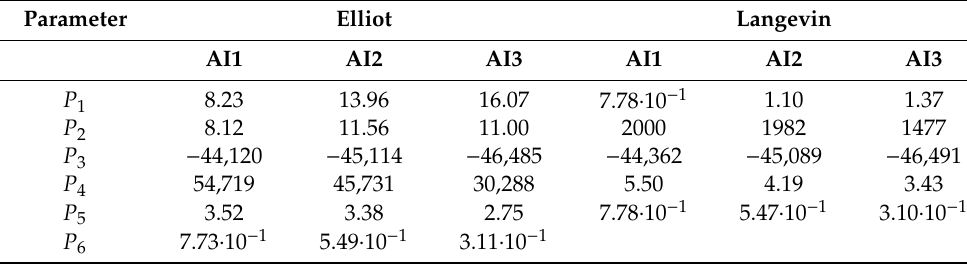
Table 20. Calculated parameters of the Alnico increasing